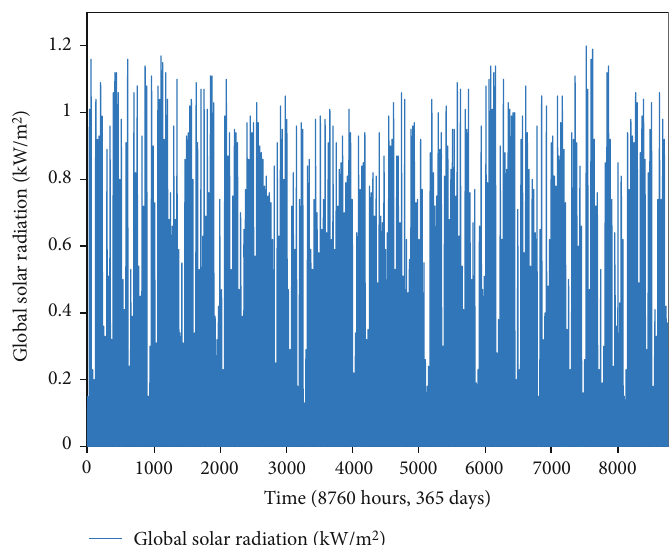
Figure 12: Global solar radiation.